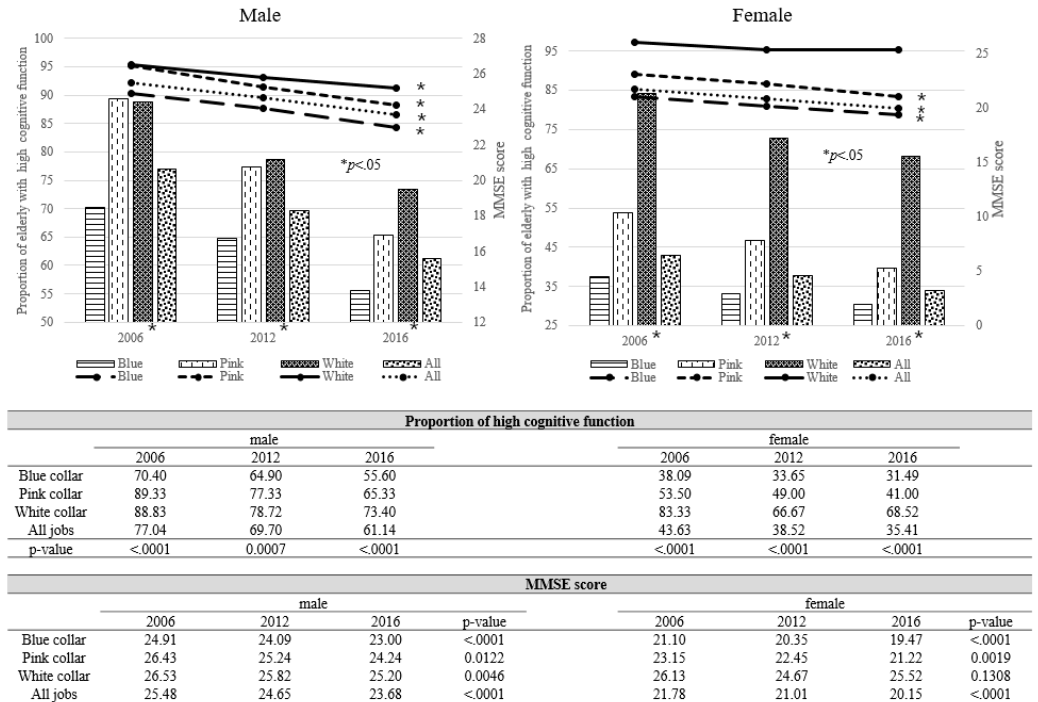
Figure 2. Gender-specific proportion of high cognitive function (K-MMSE ≥ 24) and mean scores of K-MMSE according to the occupational types over 10 years (2006, 2012, and 2016). (In male, the prevalence of high cognitive function and K-MMSE scores in all occupations decreased over the following ten years with the lowest cognitive function in blue-collar workers; in female, the proportion of subjects with high cognitive function decreased over the years with the lowest percentage of high cognitive function in blue-collar workers. K-MMSE scores significantly decreased over the years in blue and pink-collar workers.).